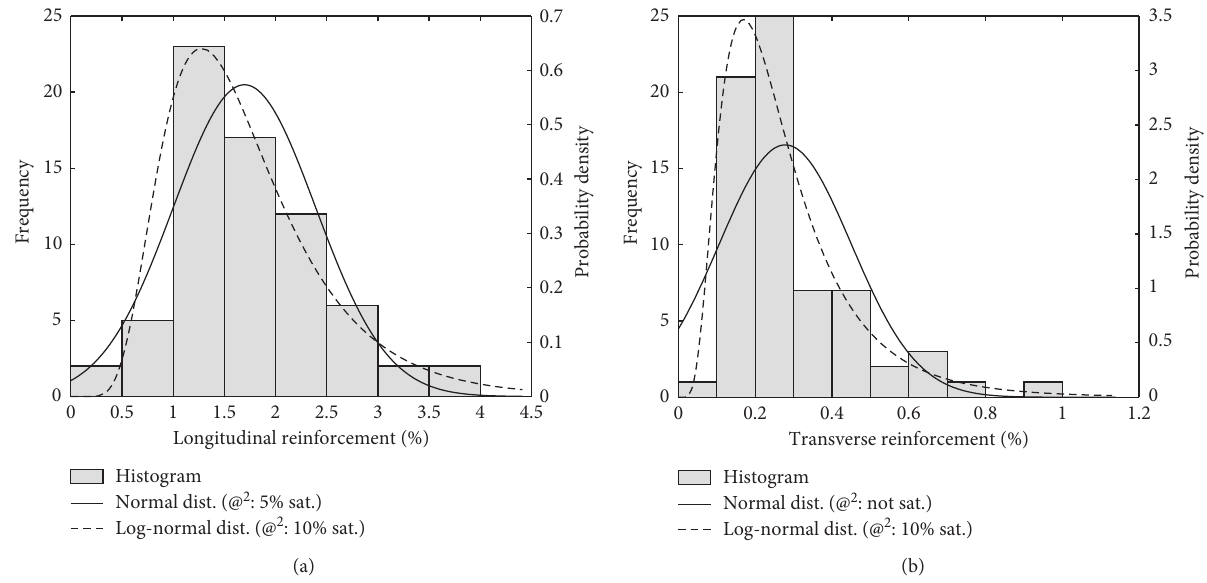
Figure 21: Histogram and probability distributions associated with the (a) columns longitudinal reinforcement ratio and (b) transverse reinforcement